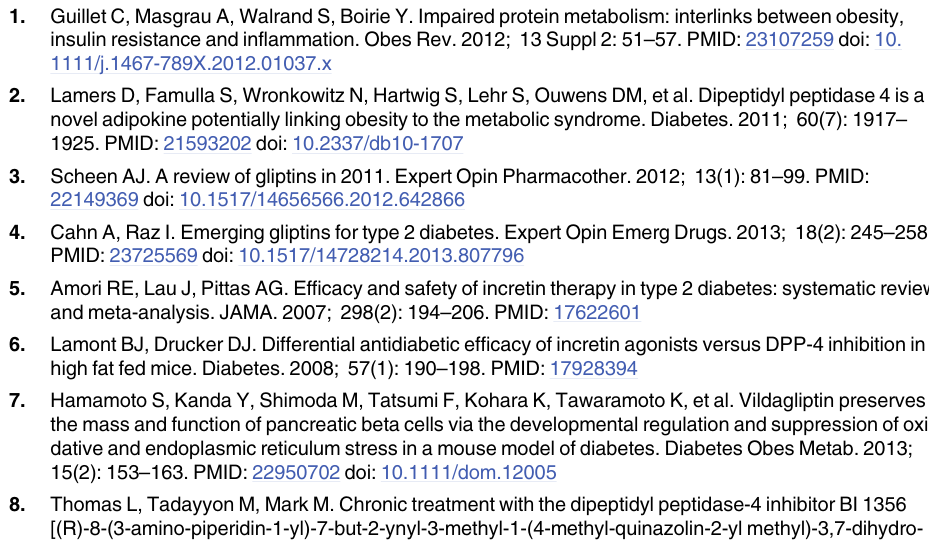
S3 Fig. Analysis of treatment effects on total energy expenditure according to the body composition.